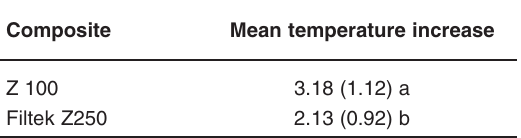
TABLE 2- Mean temperature increase ( 0 C) for Z250 and Z100 composite resins, regardless of the dentin and composite thicknesses